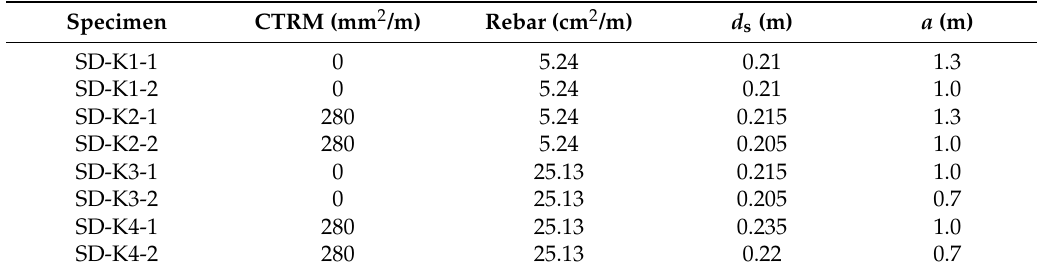
SD-K4-1, exemplarily shown in Figure